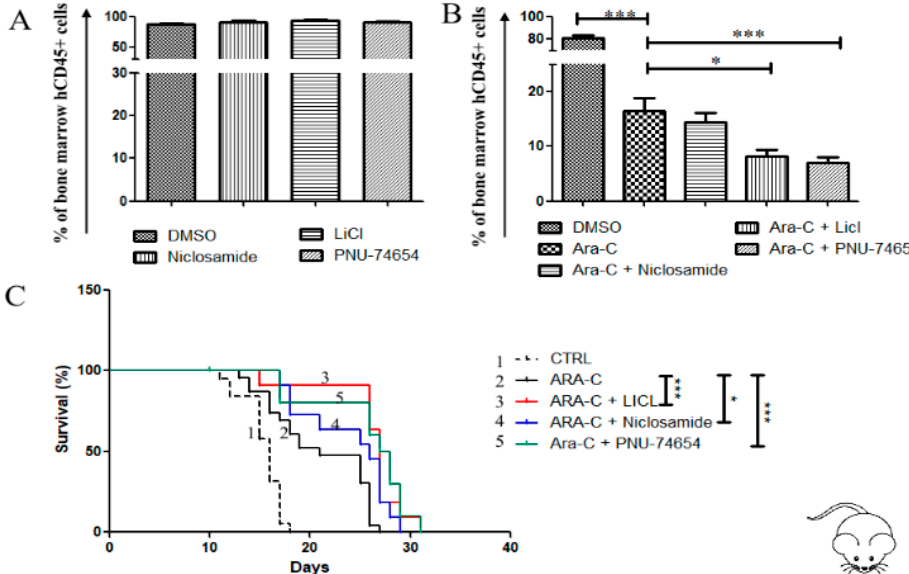
Figure 7. Wnt inhibition reduces bone marrow leukemic burden and prolongs survival of the cell line-based AML xenograftmouse model. ( A , B ) Flow cytometry analysis of human CD45 + in bone marrow samples obtained from mice transplanted with AML cell line U937. Starting from day 9 post-engraftment, mice were treated for 2 days with one of the following schedules: DMSO, Ara-C alone (25 mg/Kg), Wnt inhibitor alone, or Wnt inhibitor + Ara-C. Then Ara-C were administered for further 3 days in the groups receiving Ara-C (alone or in combination), while the other groups received DMSO. The following concentrations were used for each inhibitor: PNU-74654 0.5 mg / kg, Niclosamide 10 mg / kg, LiCl 25 mg / kg. The assay was performed with at least 5 mice in each group. Data are reported as mean ± SEM of values obtained from at least 5 mice. ( C ) Survival of mice transplanted with U937, di ff erences in survival curves were analyzed with the Log-rank (Mantel–Cox) Test, * p < 0.05, *** p < 0.001.